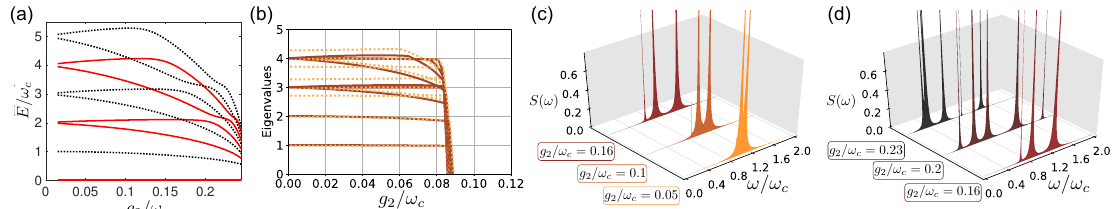
Figure 1. ( a , b ) Energy spectrum for the two-photon Dicke model (1) as a function of the coupling strength, for atoms resonant with the two-photon transition ω q = 2 ω c . Panel ( a ) shows [20] the spectrum for N = 1; different line styles denote the parity of the number of photons (positive for continuous red lines, negative for dotted black lines), which is a symmetry of ˆ H 2 ph . Panel ( b ) shows [19] the spectrum for N = 3, the solid red line corresponds to the two-photon Dicke ˆ H 2 ph , while the yellow dashed line corresponds to the model obtained including inter-spin couplings J ∑ N − 1 J = 0.2 ω c . ( c , d ) Fluorescence spectrum [20] in arbitrary units of the output signal under coherent drive, for different values of the coupling strength. In ( c ) is shown the transition from the strong to the USC regime, while in ( d ) the fluorescence spectrum bears a direct signature of the onset of the spectral